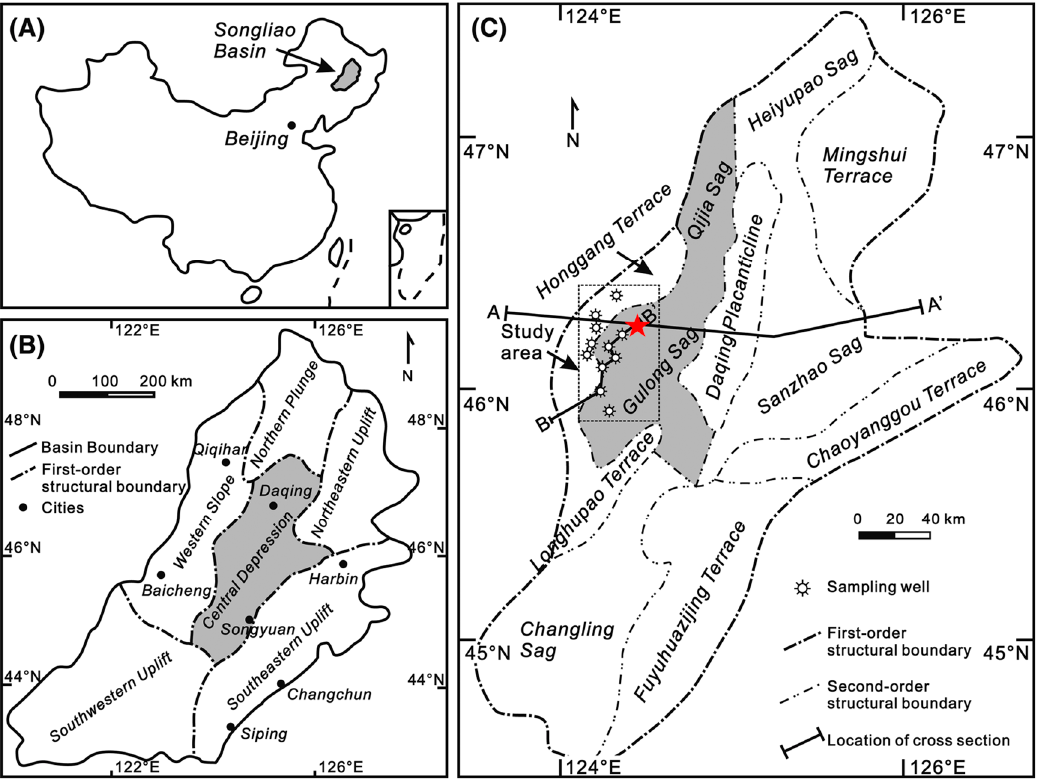
Figure 1. Location of the Songliao Basin on a generalized map ( A ). Central Depression ( B ). Well locations in the study area (the Gulong Sag) ( C ). (Modified from Liu et al., 2019 [27]).